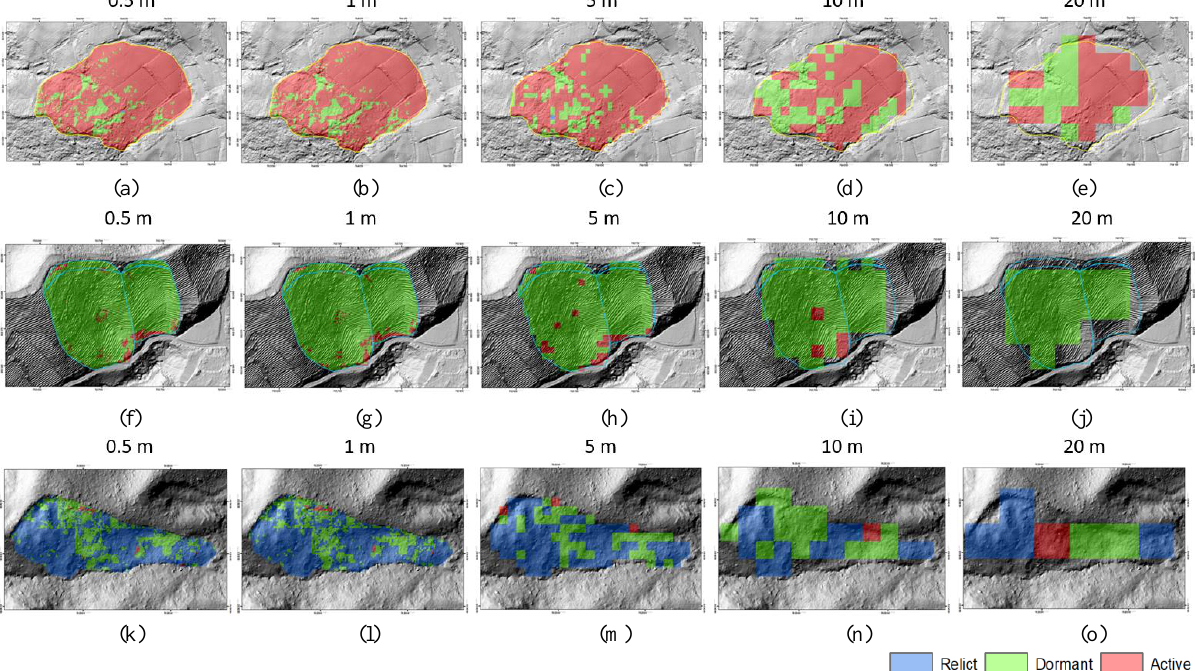
Figure 4 . Sample of classified landslide activity for deep-seated translational landslide with different spatial resolution using SVM RBF-GS method where, (a) – (e) for active, (f) – (j) for dormant, and (k) – (o) for relict